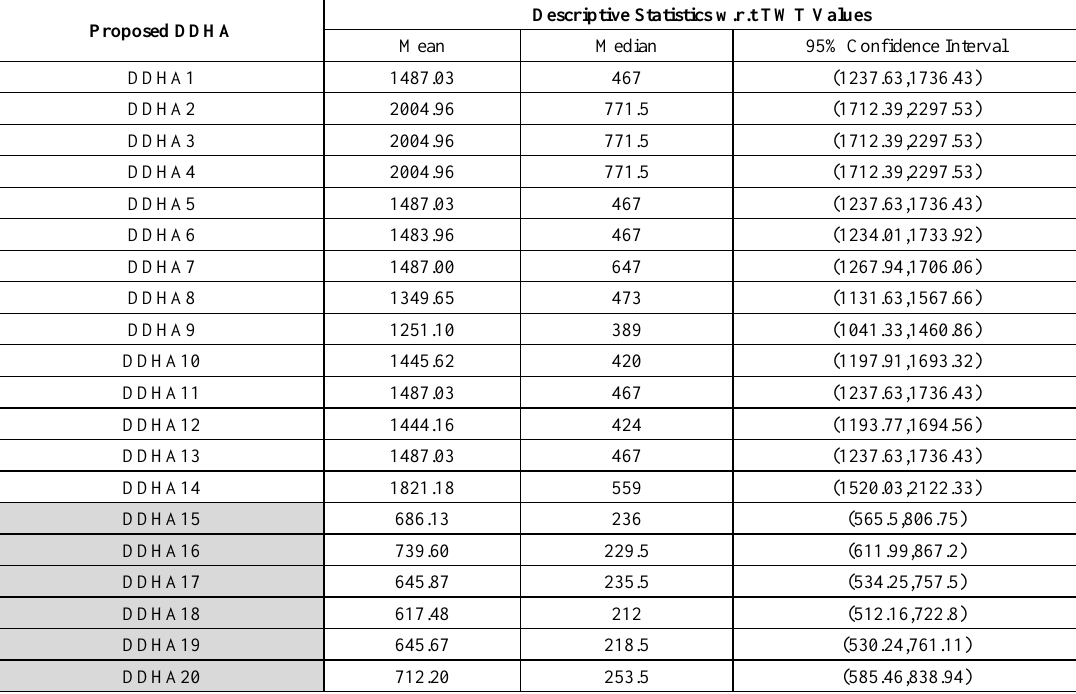
Table 4. Descriptive statistics, w.r.t. TWT values, of proposed 20 variants of